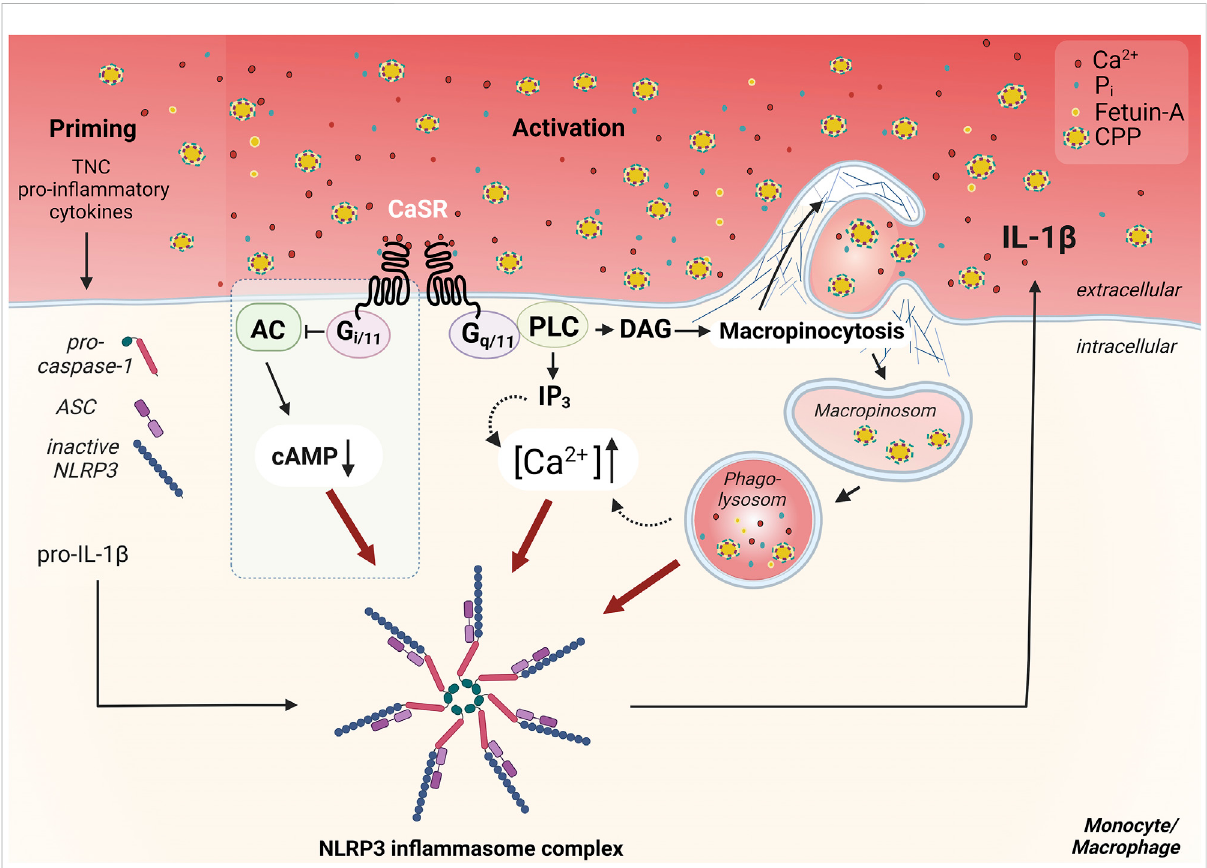
FIGURE 1 Overview of the CaSR dependent mechanism of Ca 2+ /CPP-induced in fl ammasome activation in monocytes/macrophages. CaSR-induced signaling pathways important for NLRP3 in fl ammasome activation, are induced by coupling to G protein dimers. Signal transduction via Gq/ 11 induces the activation of phospholipase C (PLC), which completes the hydrolysis of phosphatidylinositol 4,5-bisphosphate in inositol trisphosphate(IP3) and diacylglycerol (DAG). IP3 leads to release of Ca 2+ from intracellular calcium stores. The resulting increasein intracellular Ca 2+ concentration ([Ca 2+ ]) triggers various signal transductions and presumably contributes to the activation of the NLRP3 in fl ammasome. CaSR- mediated Gi/o pathway activation, which has been described in macrophages (Lee et al., 2012) but not in monocytes (Rossol et al., 2012b), leads to inhibitionofadenylatecyclase(AC)andreductionofcellularcAMPlevel.ThedownregulationofcAMPdiminishesitsinhibitoryeffectontheassembly of the in fl ammasome, therefore allowing for its activation (blue box) (Lee et al., 2012). Activation of CaSR also contributes to constitutive macropinocytosisinmonocytes/macrophagesandleadstoaccumulationofcertainlipidmediators.Theseleadtoactinpolymerization via induction of speci fi c GTPases such as Rac1/2, resulting in Arp2/3-dependent branching of the actin network. CaSR-mediated macropinocytosis allows the uptakeofcalciproteinparticles(CPPs)fromtheextracellularspace.Theseamorphousparticlesareformed via bindingofCa 2+ andphosphateions(Pi) by the serum protein fetuin-A. The uptake and internalization of these particles is pivotal for the activation of the in fl ammasome and induce an additionalincreaseincytosolic[Ca 2+ ].Theprimingnecessaryfortheassemblyofthein fl ammasome,whichisrequired,forexample,fortheprovision of pro-IL-1 β , ASC, and pro-caspase-1, can be mediated by cytokines in the in fl ammatory context, or by endogenous toll-like receptor ligands like tenascin-C (TNC) in synovitic joints in rheumatoid arthritis. Figure modi fi ed according to (Jäger et al., 2020) and created with